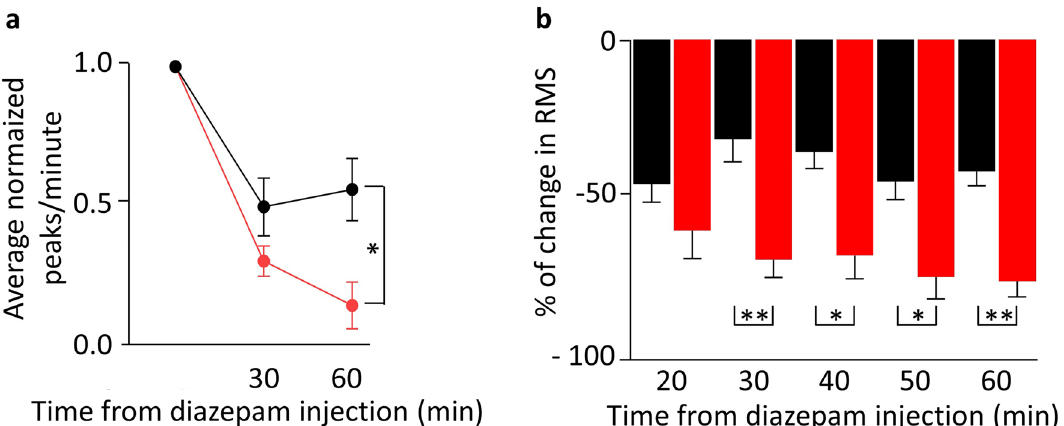
Figure 3. ( a ) Average number of spikes at different time points after diazepam injection (doses 1.25 mg/kg, i.p.). Black dots represent data obtained from animals exposed to sham whereas red dots represent animals exposed to real magnet. Note that the data is normalized. ( b ) Bar histogram representing the percentage of reduction in the spontaneous Root Mean Square (RMS) at different time points after diazepam injection (doses 1.25 mg/kg, i.p.). Black bars, sham rats; red bars, magnet rats. In both cases ( a , b ), data represented 5 min